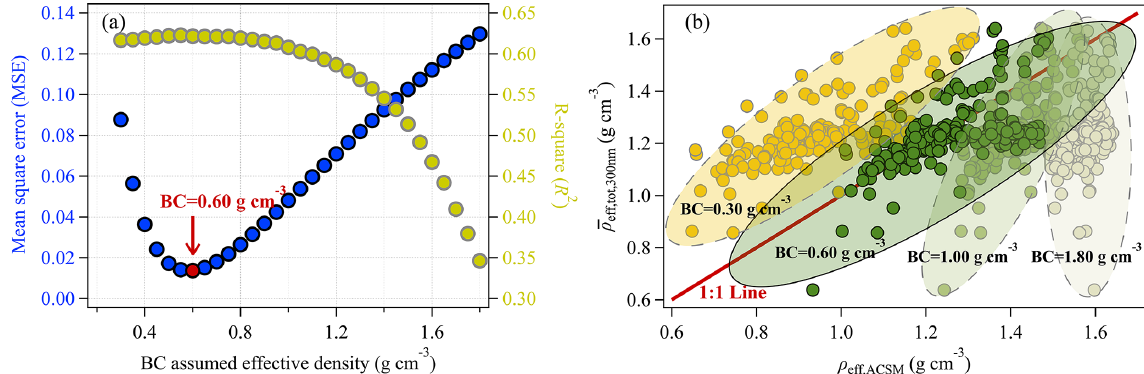
Figure 7. (a) Mean squared error (MSE) and R -squared ( R 2 ) results from a BC effective density sensitivity test. (b) Comparison of the average effective density of particles at 300nm observed by DMA–CPMA–CPC ( ρ eff , tot , 300nm ) and ACSM-derived bulk effective density ( ρ eff , ACSM ). The shaded areas represent ρ eff , ACSM based on different BC effective density assumptions. The red line shows a slope of 1.